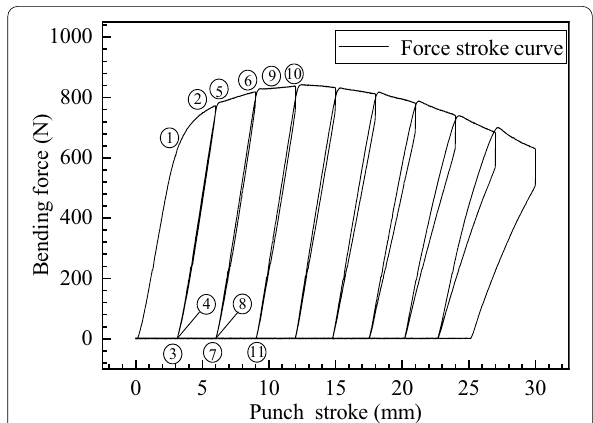
Figure 6 Force-stroke curve of repeated loading and